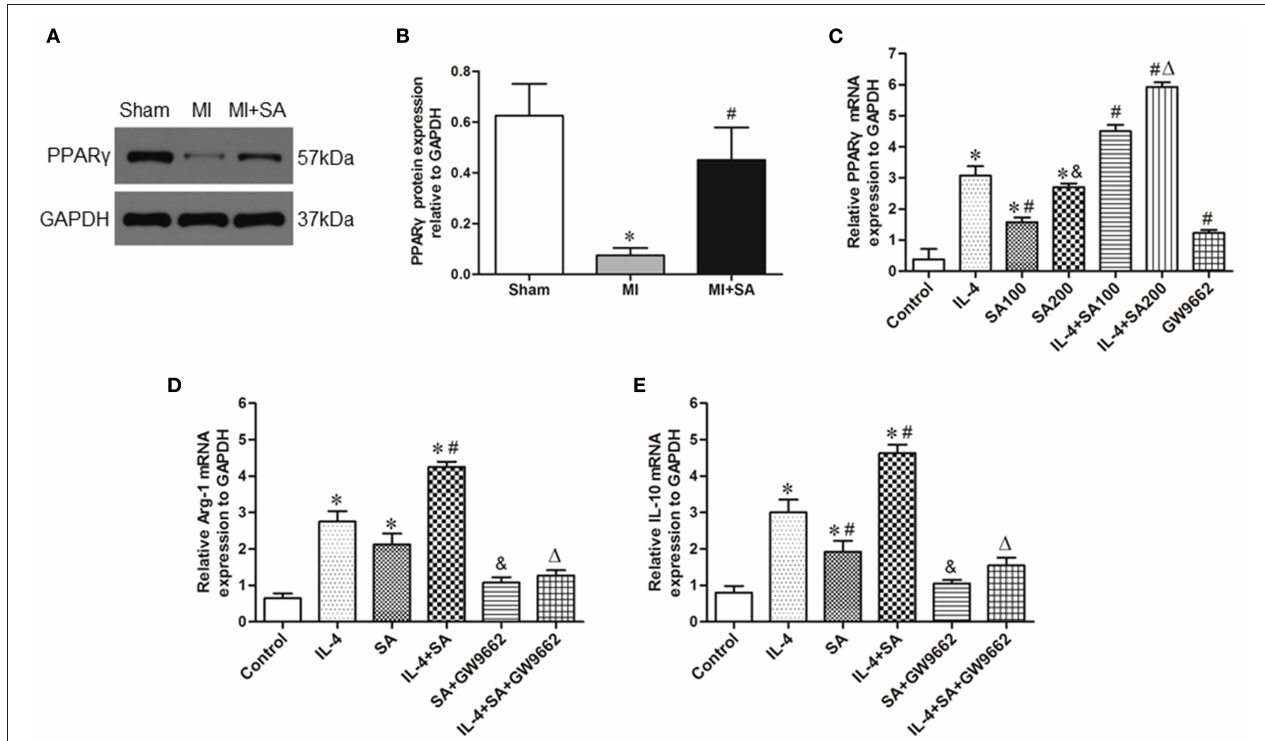
FIGURE 8 | SA activated the expression of PPAR γ and the effect of SA on BMDMs. (A,B) PPAR γ protein expression was detected by Western blot analysis. *Compared with the sham group, P < 0.05, # Compared with the MI group, P < 0.05. (C) PPAR γ mRNA expression in BMDMs and IL-4-treated BMDMs after SA treatment. *Compared with the control group, P < 0.05; # Compared with the IL-4 group, P < 0.05; & Compared with the SA100 group, P < 0.05; 1 Compared with the IL-4 + SA100 group, P < 0.05. (D,E) The effect of SA on Arg1 and IL-10 mRNA expression in BMDMs and IL-4-treated BMDMs and the effect of the PPAR γ antagonist GW9662 on SA-induced Arg1 and IL-10 expression. *Compared with the control group, P < 0.05; # Compared with the IL-4 group, P < 0.05; & Compared with the SA group, P < 0.05; 1 Compared with the IL-4 + SA group, P < 0.05. n = 6 in each